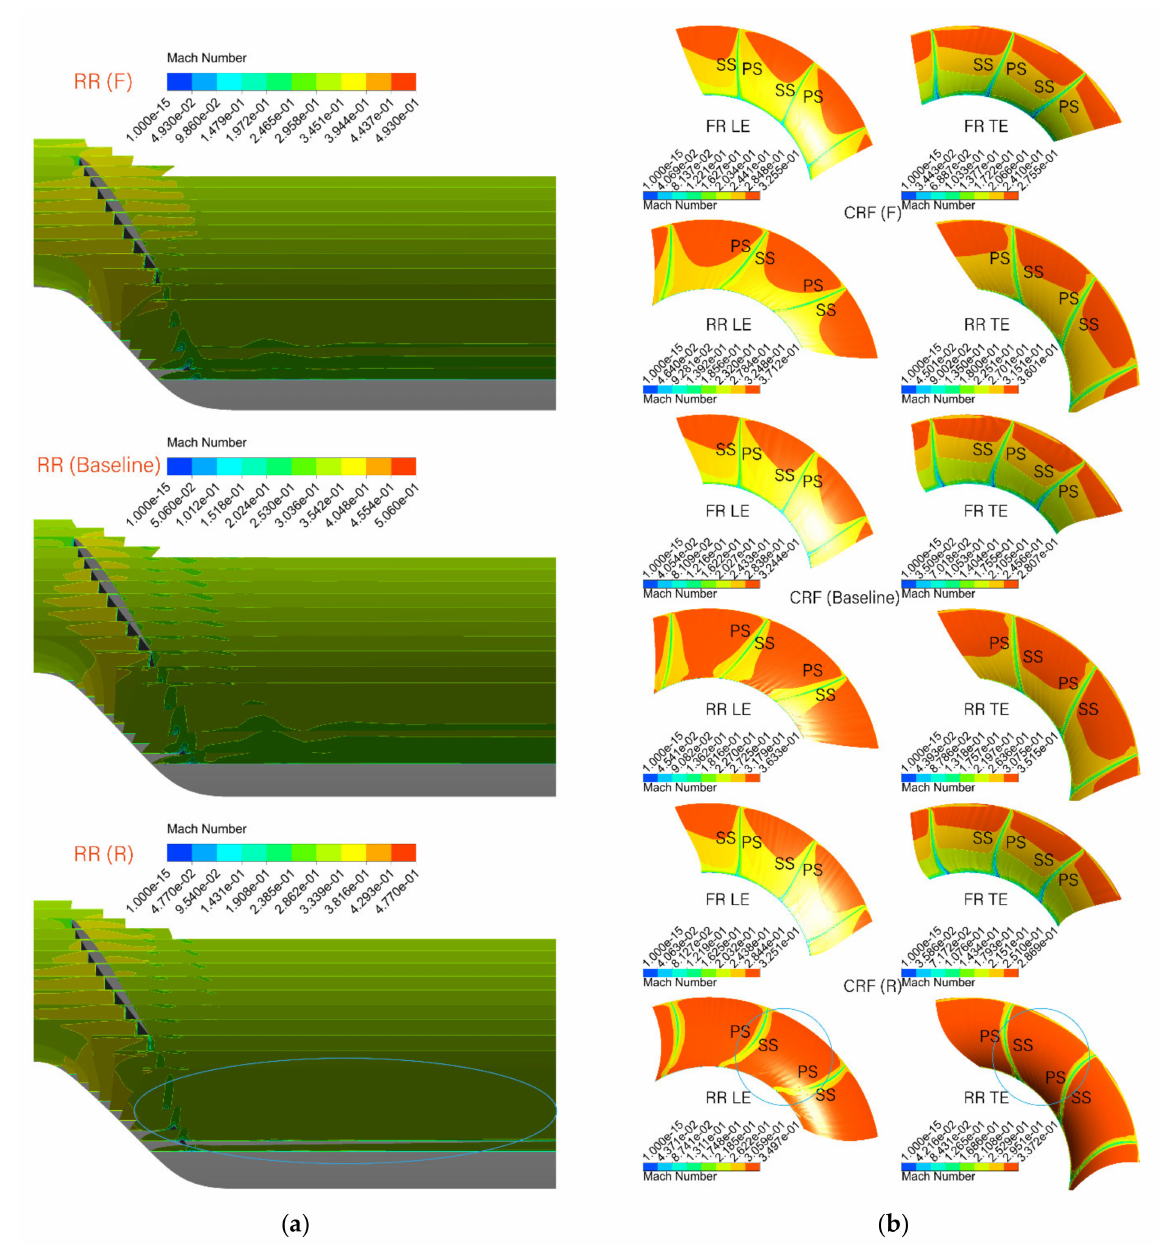
Figure 17. ( a ) Comparison of RRs based on the Mach number contour at the choke points; ( b ) comparison of three sets of CRFs based on the Mach number contour at the choke